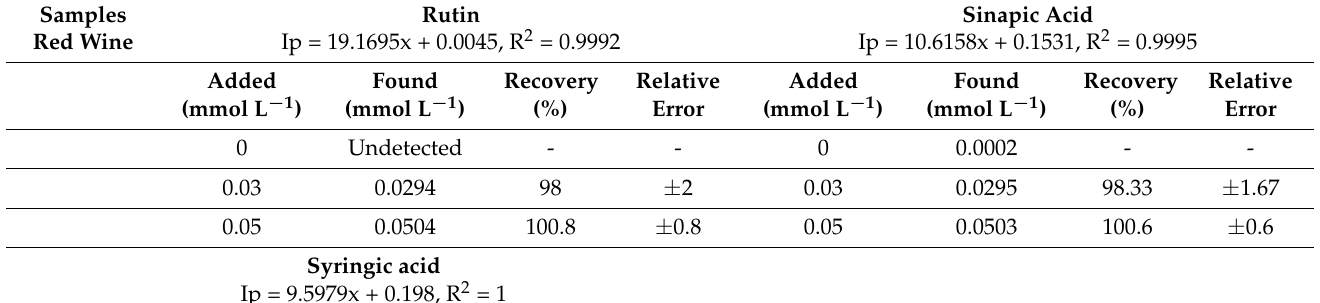
Table 6. Results of the determination of phenolic compounds in wine samples (red and white wine) using Fe 3 O 4 nanoparti- cles modified CPE. Samples Red Wine